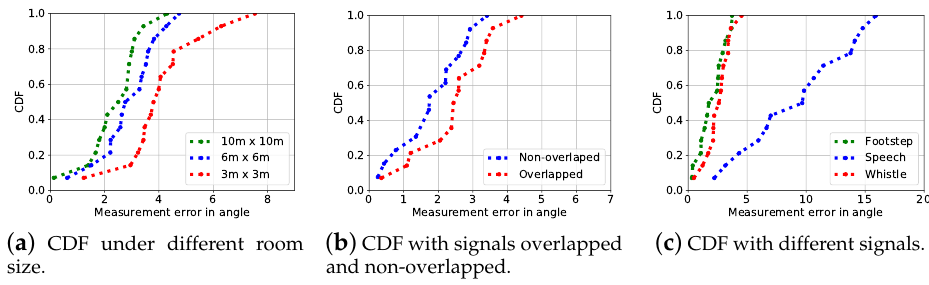
Figure 5. Source localization errors under different room size ( a ), emulating the severity of multipath effect. ( b ) The source localization errors with signals overlapped and non-overlapped exhibit no obvious differences. ( c ) Source localization errors with different type of signals.